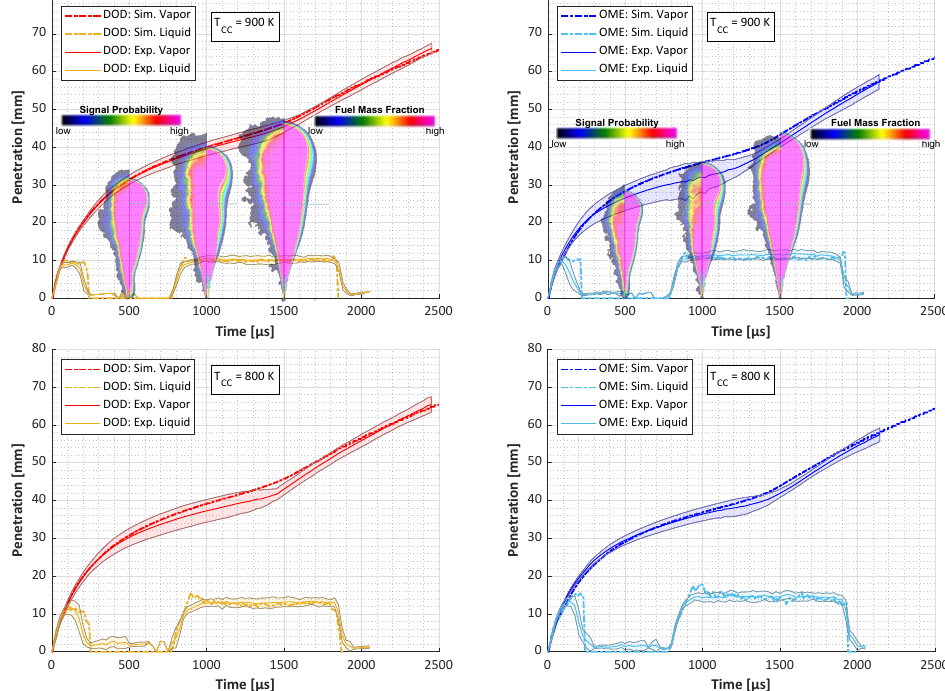
Figure 9. Conti3L: Multi-injection (t inj = 300/500/1200 µ s) spray penetration (projected liquid volume and vapor) for inert conditions: ( top ) AiM : T CC = 900 K. ( bottom ) T2iM : T CC = 800 K. ( left ) Dodecane. ( right )